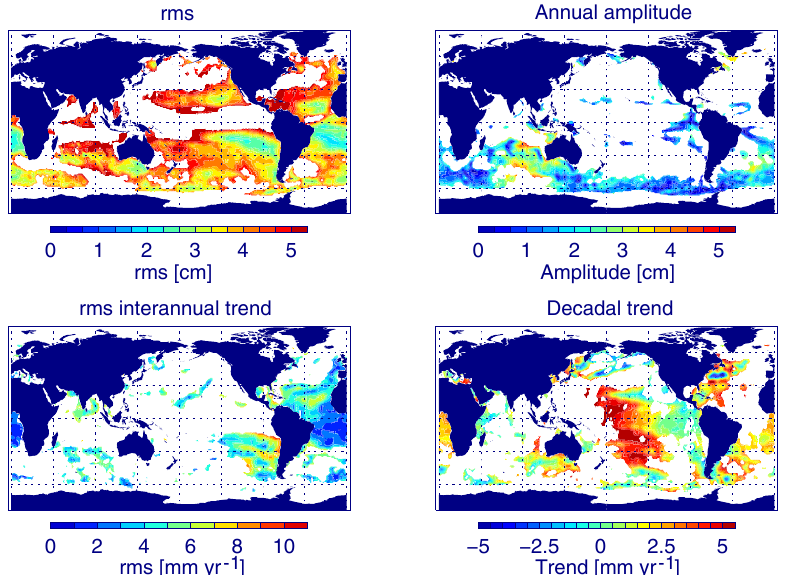
Figure 9. The rms of sea level, annual amplitude, rms of interannual (5-year) running trend, and decadal trends from TOPEX altimeter data for the period February 1993–October 2005. Colour coded are sea level values for which the local orbit errors (estimated from GFZ minus GRGS) reach more than 10% of the local sea level values. All other regions are masked out